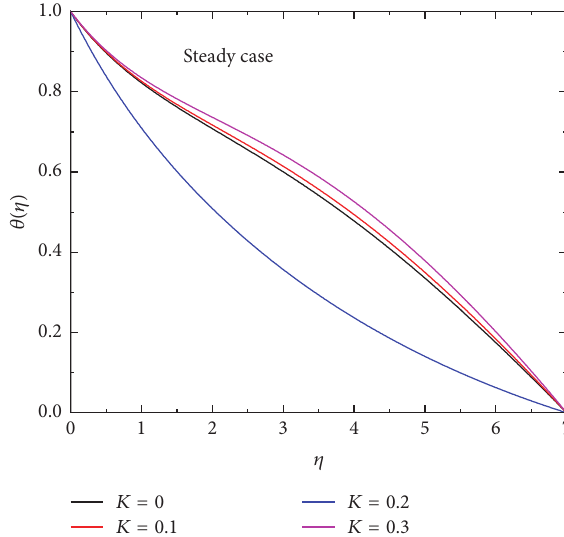
Figure 2: Velocity profiles for various values of 𝐾 when 𝐴 = 0 , 𝑅 = 0.5 , and 𝜉 = 0 .